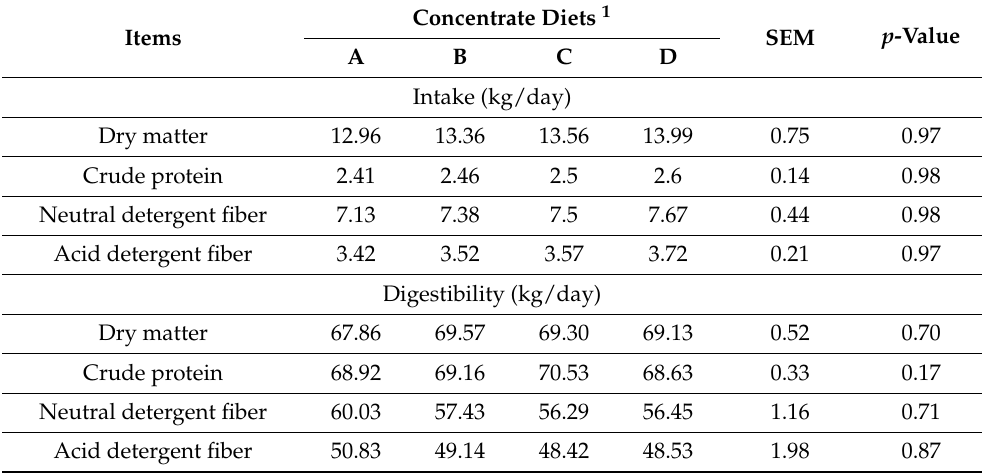
Table 3. Effect of different levels of yeast-fermented citrus pulp on nutrient intake and digestibility. Items